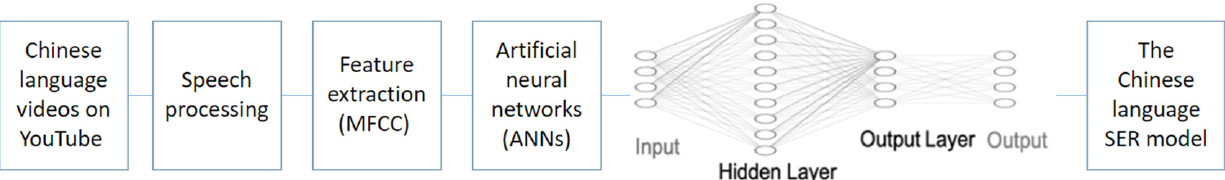
Figure 4. SER model structure.